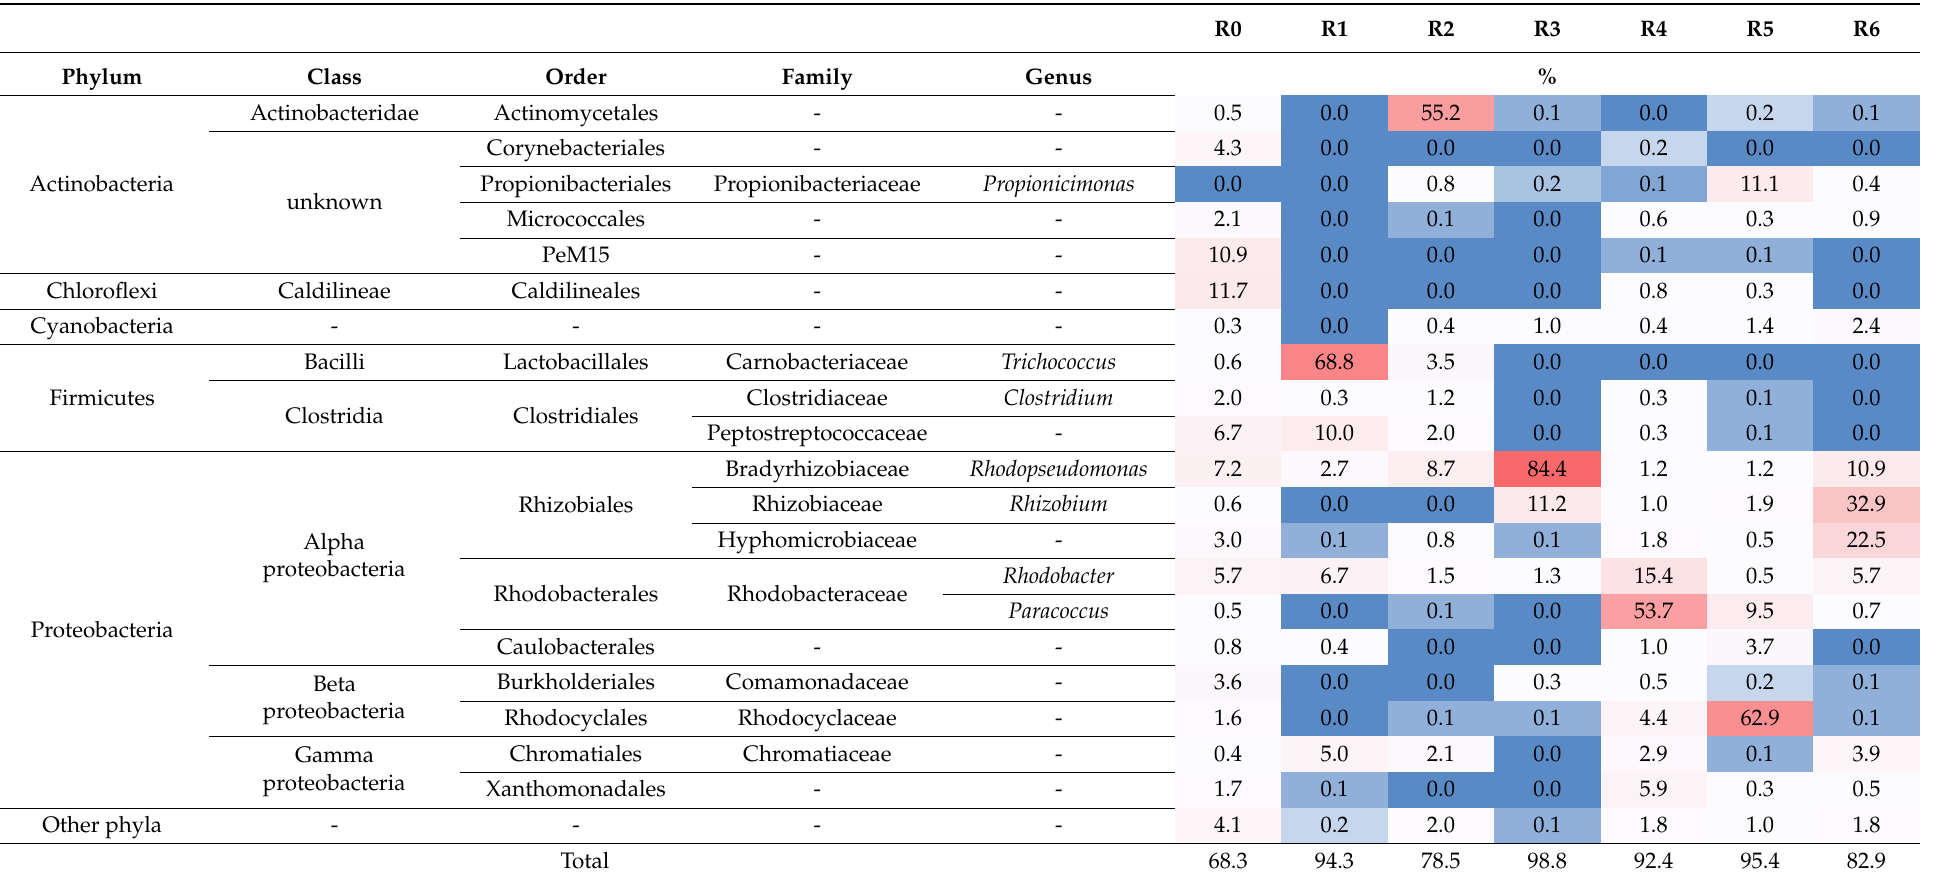
Table 3. Heatmap of the most abundant taxonomic groups ( ≥ 2% of abundance in at least one sample) identified in PMCs fed with a fermented mixture of molasses less abundant to more and domestic wastewater.